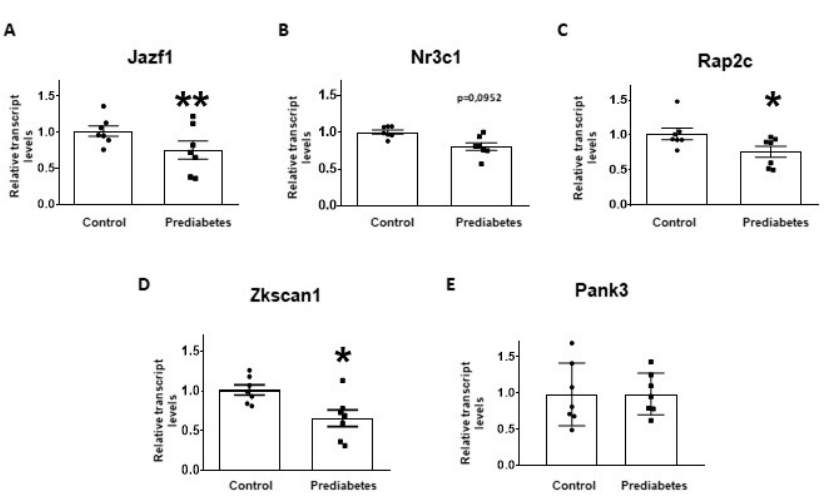
Figure 3. Relative mRNA expression of ( A ) Juxtaposed with another zinc finger protein 1 ( Jazf1 ); ( B ) Nuclear receptor subfamily 3 group c member 1 ( Nr3c1 ); ( C ) RAP2C, member of RAS oncogene family ( Rap2c ); ( D ) Zinc finger with KRAB and SCAN domains 1 ( Zkscan1 ); and ( E ) Pantothenate kinase 3 ( Pank3 ) in prediabetic rat left ventricle samples (prediabetes) as compared to vehicle-treated controls (control). The transcript levels were normalized to Hypoxanthine-guanine phosphoribosyltransferase ( HPRT ) mRNA. Data are expressed in arbitrary units as means ± SEM. n = 7, * p < 0.05, ** p < 0.01 versus control; unpaired Student’s t -test.